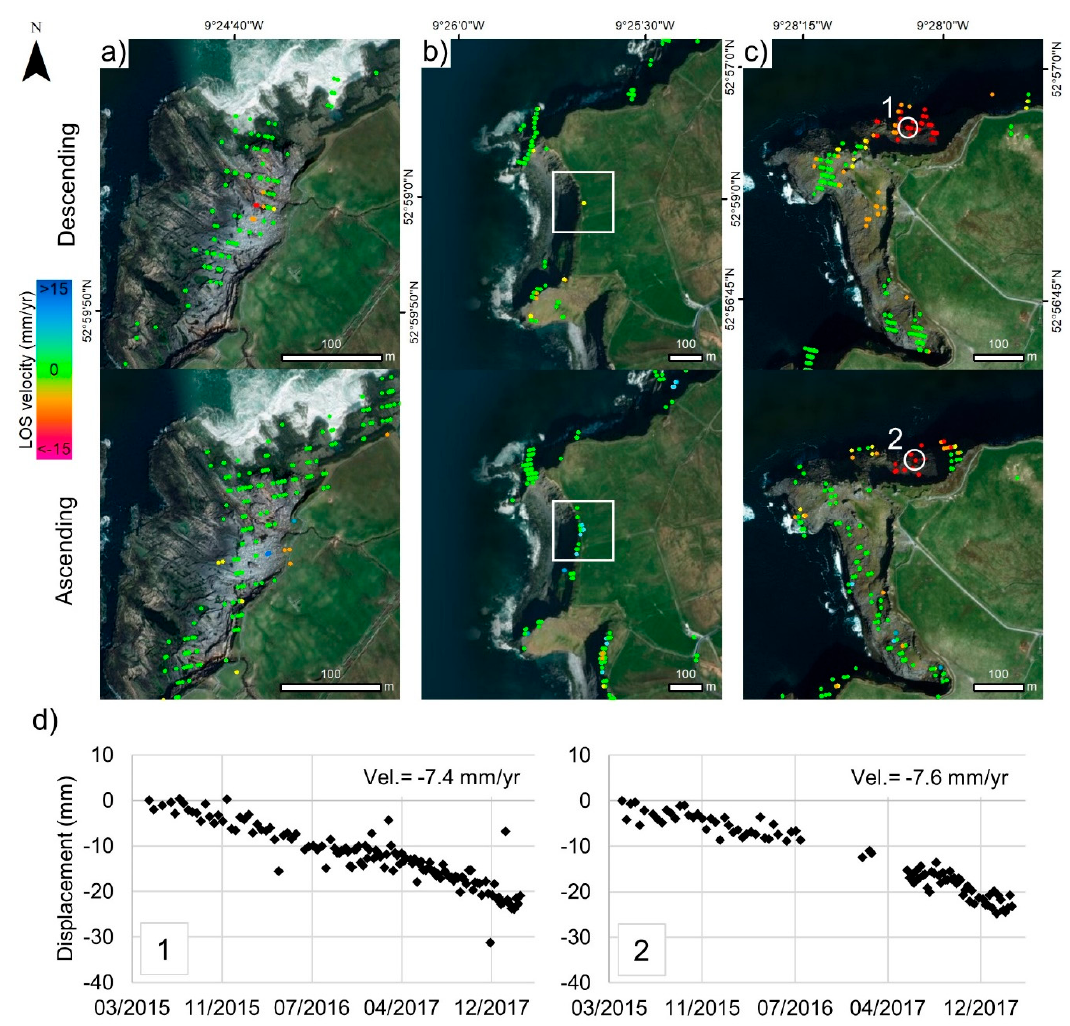
Figure 13. Example of slope instabilities occurring along the coastline in West Ireland (Co. Clare), as observed by descending (top row) and ascending (middle row) tracks. ( a ) Instability on the coast between the village of Doolin and the Cliffs of Moher, denoted locality ‘h’ in Figure 7. ( b ) Instability at the Cliffs of Moher (white square), denoted locality ‘i’ in Figure 7. ( c ) Instability at Hag’s Head at the Cliffs of Moher, denoted locality ‘l’ in Figure 7. Note that the northern flank of the Hag’s Head promontory is largely in shadow in this image. ( d ) The displacement time series of the selected point (white circle) is presented for the descending ( 1 ) and ascending ( 2 ) tracks.